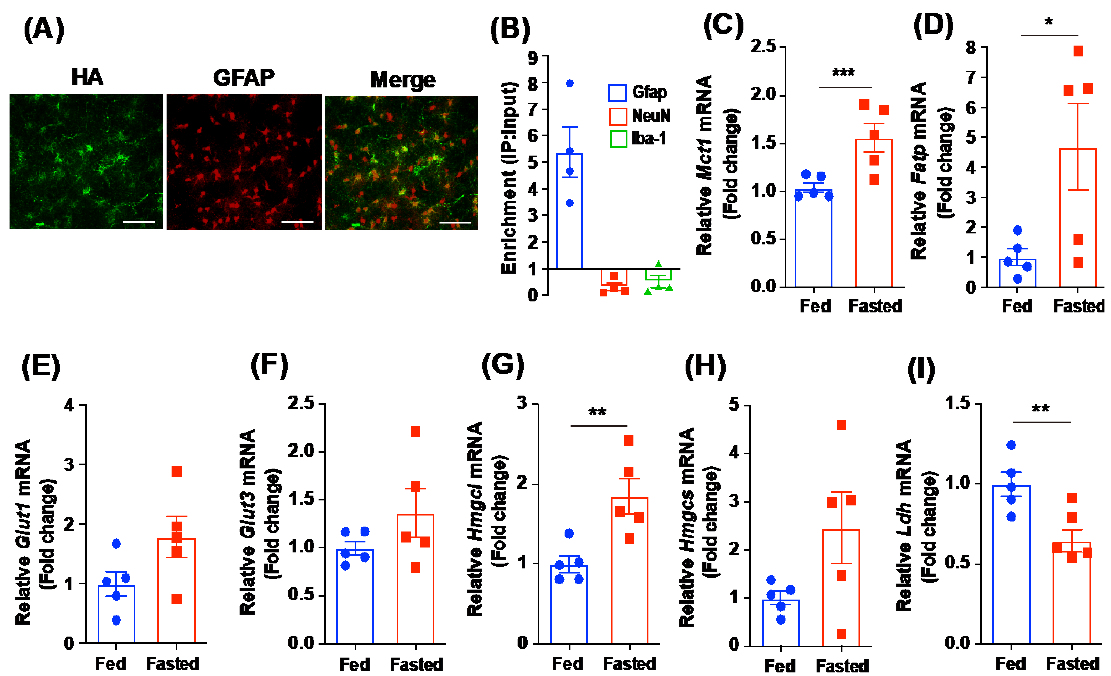
Figure 4. Altered mRNA levels of genes involved in metabolic processes in purified mRNA of hy- pothalamic astrocyte in response to short-term food deprivation. Astrocyte-specific expression pat- terns of mRNA were measured in both control and fasted mice using qPCR and Ribo-tag experi- ments. ( A ) Representative images showing the co-localization of HA and GFAP immunosignals in the hypothalamic arcuate nucleus. ( B ) Purification of astrocytic mRNA was confirmed by evaluating the enrichment of Gfap , NeuN , and Iba1 expressions. Fasted mice showed a significant elevation in the levels of astrocytic mRNA involved in metabolic processes, including ( C ) Mct1 , ( D ) Fatp , and ( G ) Hmgcl , and a tendency toward increased mRNA levels of ( E ) Glut1 , ( F ) Glut3 , and ( H ) Hmgcs in the hypothalamic astrocytes. ( I ) A significant decrease in astrocytic Ldh mRNA was observed in the hypothalamus of the fasted mice. Data are presented as the mean ± SEM. n = 5 mice per group. * p < 0.05, ** p < 0.01, *** p < 0.001. Scale bar = 50 μm. 3. Discussion Considerable attention has been paid to identifying the physiological and pathologi- cal relevance of metabolic activities in hypothalamic cells in whole-body energy homeo- stasis. Metabolic coupling between neurons and glial cells in the hypothalamus is an im- portant cellular event that drives appropriate behavioral outputs [5,6]. In this study, hy- pothalamic metabolites were profiled in response to short-term food deprivation and re- lated molecular data were obtained. Previous studies indicated that the types and patterns of fuel utilization in hypothalamic cells, including appetite-regulating neurons, astrocytes, and microglia, are directly connected to the regulation of energy metabolism [5,12,13]. For instance, altered mitochondrial dynamics occurred in hypothalamic neurons of rodent models of obesity, in which cellular metabolism was genetically modified [4]. We identi- fied that multiple nutrients, which can be used for neuronal excitability and synaptic plas- ticity, were altered in the fasted hypothalami. γ -aminobutyric acid (GABA) released from AgRP neurons exerts the orexigenic responses via the inhibition of POMC neurons [3,14]. We confirmed that fasted mice showed an increase in GABA content in the hypothalamus. Previous studies showed that alterations in leucine metabolism are coupled to a variety of metabolic processes [15,16]. In agreement with these findings, we confirmed that the levels of hypothalamic leucine were elevated in fasted mice retaining altered metabolic activity, such as hyperphagia and hypoglycemia. Lactate exerts neuronal activity in hy- pothalamic neurons that controls whole-body energy metabolism, and the shuttling of